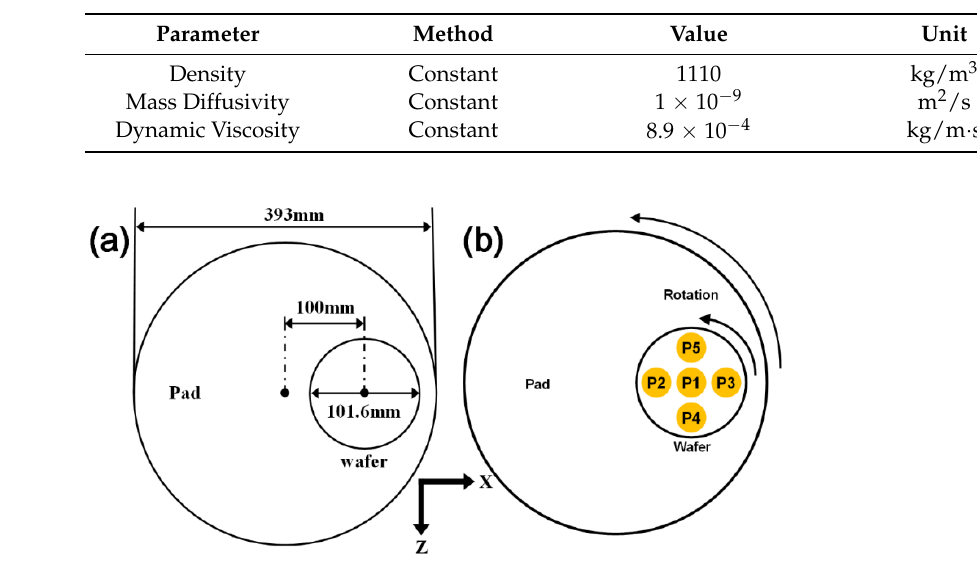
Table 2. Slurry simulation settings.